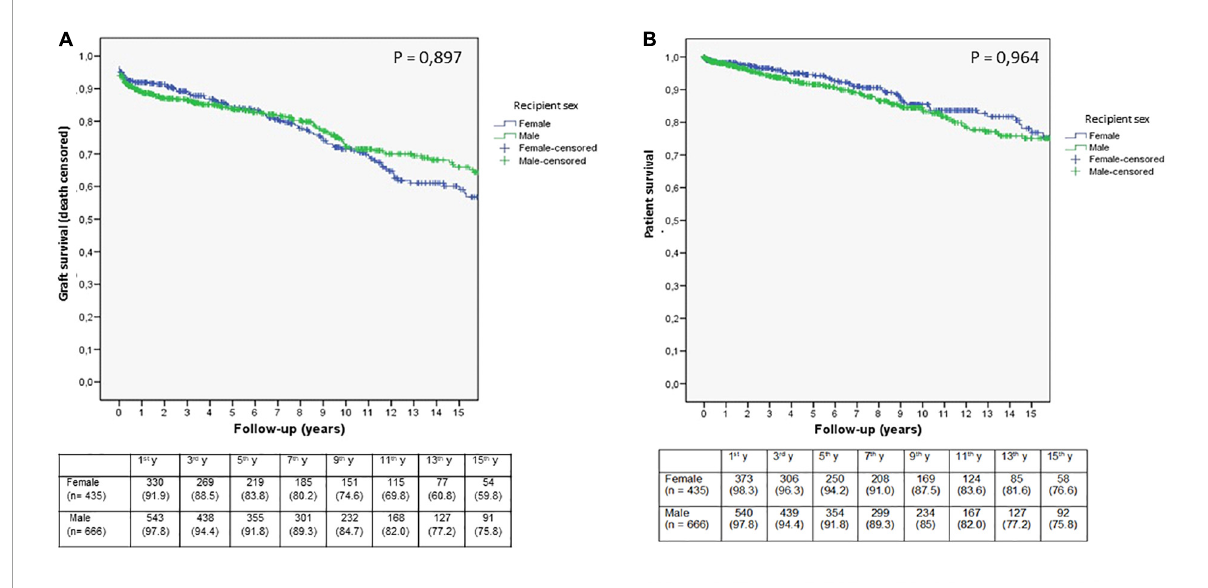
FIGURE1 Kaplan-Meier estimates of death-censored graft (A) and patient survival (B) according to recipient sex in the whole study population. The number of patients at risk during follow-up is indicated in the table below the figures ( n = 1,101).